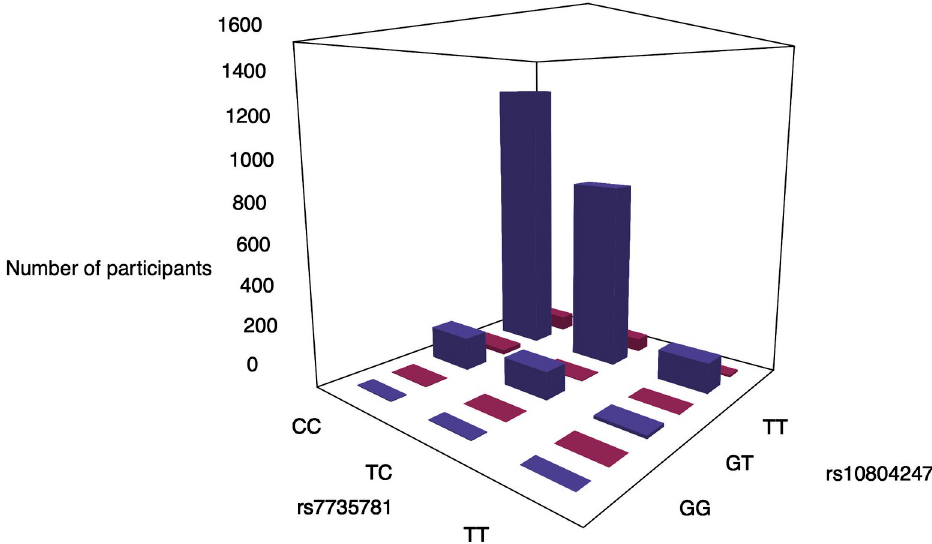
Fig 8. Genotypes combinations between rs7735781 and rs10804247 for the participates with venous thrombosis or pulmonary embolism under Biofilter filtering. The genotypes of each SNPs were plotted with the number of the participants with venous thrombosis or pulmonary embolism (cases: red) or not (controls: purple).